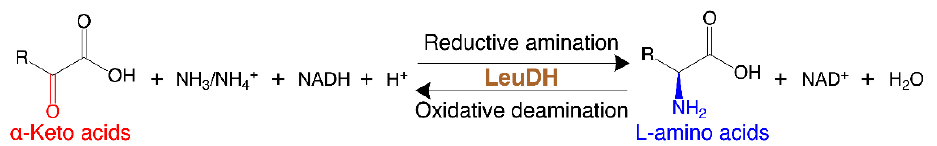
Figure 1. LeuDH-catalyzed reversible amination of α -keto acids to yield L-amino acids.